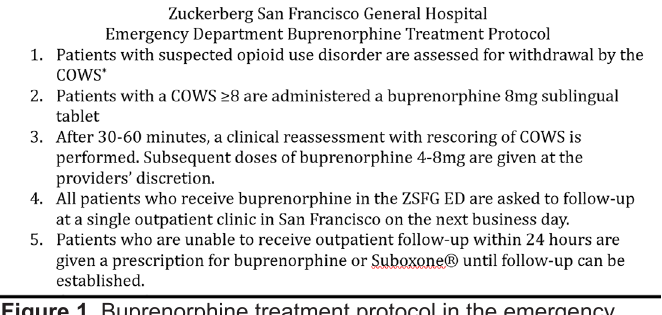
Figure 1. Buprenorphine treatment protocol in the emergency